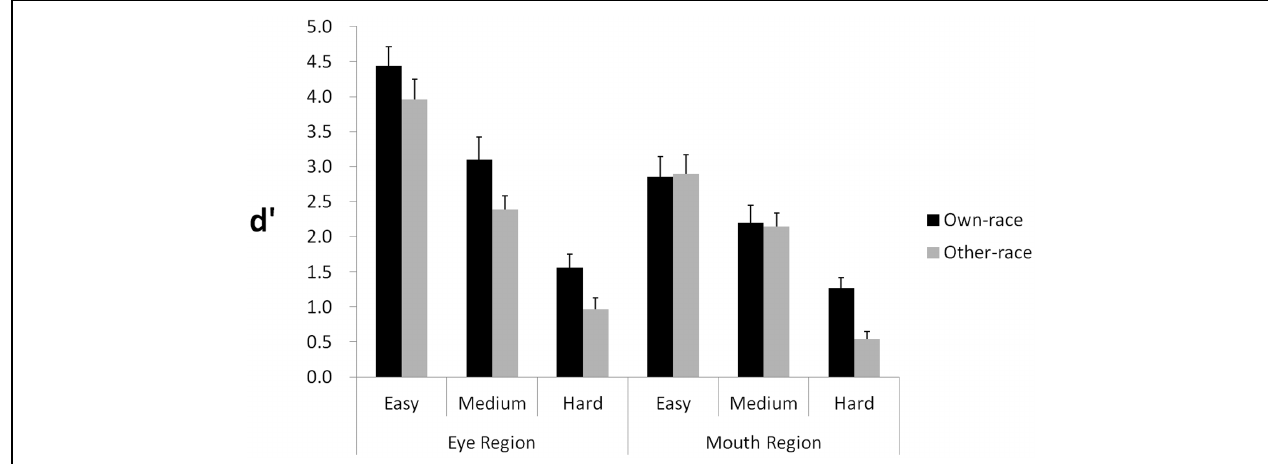
FIGURE 4 | Experiment 2: manipulating the size of facial features. The graph shows d (cid:3) scores for detecting size differences across three levels of change (easy, medium, hard) in the eye and mouth regions, respectively. Error bars represent SEs in each condition.